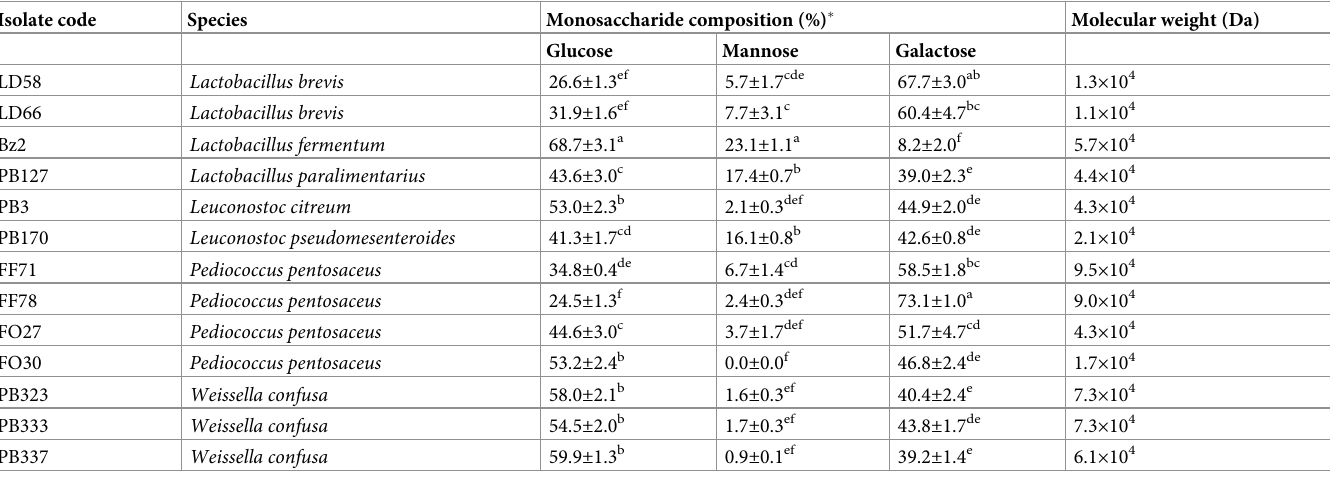
� Mean value of two replicates ± standard deviation. Values in a column with different letters are significantly different (Tukey-Kramer’s Honest Significant Difference test, p <